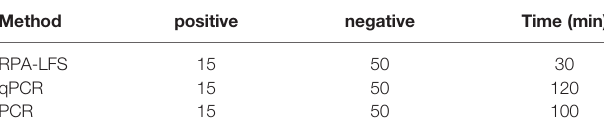
TABLE 2 | Assay performance of the RPA-LFS system and PCR. Method